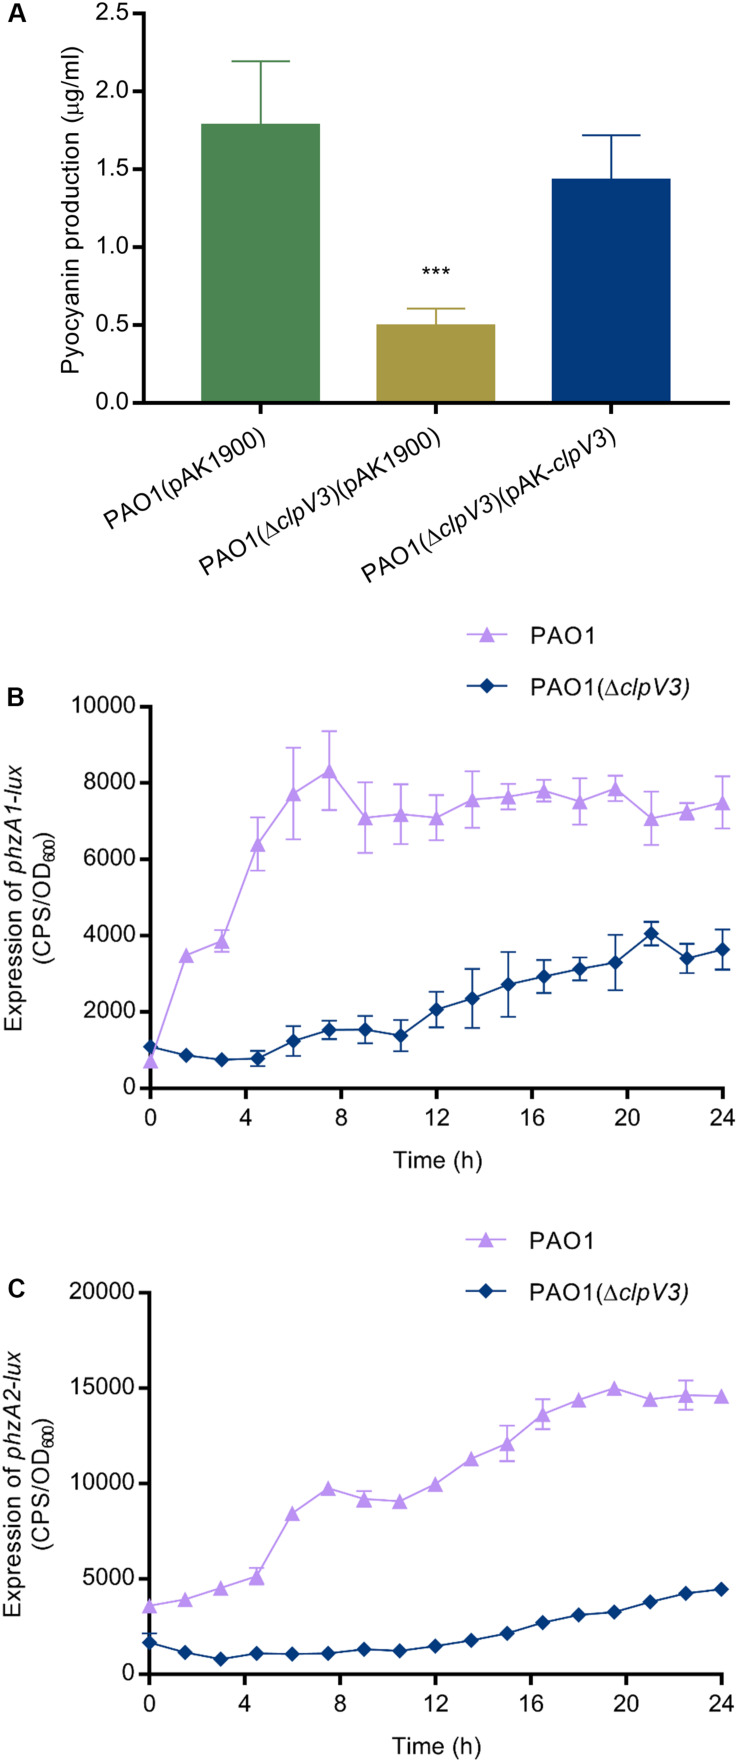
Reduced pyocyanin production and decreased expression of phzA1 and phzA2 in PAO1(ΔclpV3). (A) Comparison of pyocyanin production in PAO1(ΔclpV3),the wild-type PAO1 and the complementation strain. The experiment was independently performed three times. Unpaired Student’s t-test was used to analyze the data. ***p < 0.001. (B,C) Reduced promoter activities of two pyocyanin synthesis gene clusters phzA1 and phzA2 in PAO1(ΔclpV3). The promoter activity is presented as light production (counts per second, cps) normalized to OD600. The experiment was independently performed three times. Error bars indicate standard deviations.